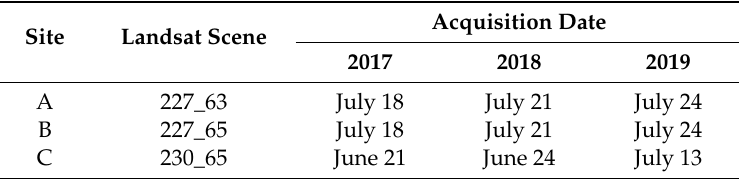
Table 1. Acquisition dates for each site and corresponding Landsat scenes.